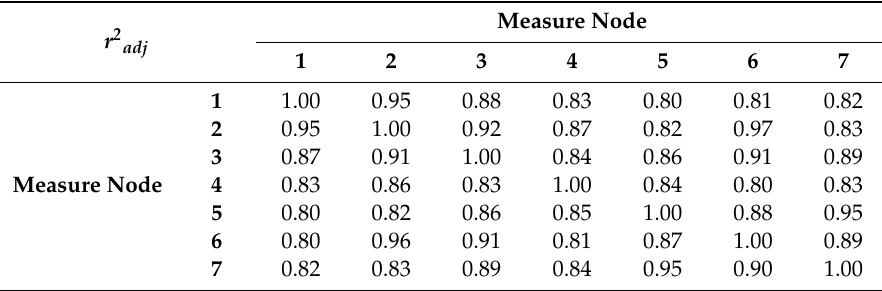
Table 10. r 2 adj of column I in case